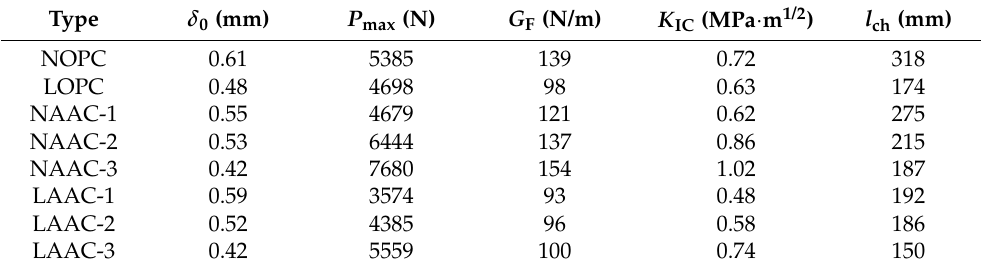
δ 0 represents the displacement at the failure